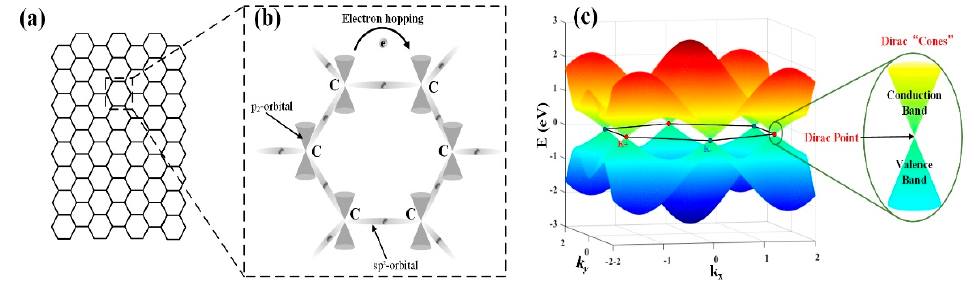
Figure 2. Graphene. ( a ) Monolayer carbon atoms arranged in a honey-comb lattice, ( b ) Electronic hopping and ( c ) The six contact points of the conduction band and valence band are all Dirac points on the Fermi surface [16]. Ref. [1]. Copyright 2014, Elsevier